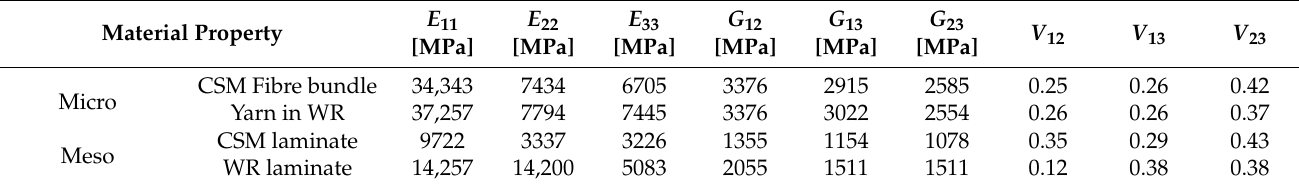
Table 3. Micro- and meso-scale elastic properties in CSM and WR